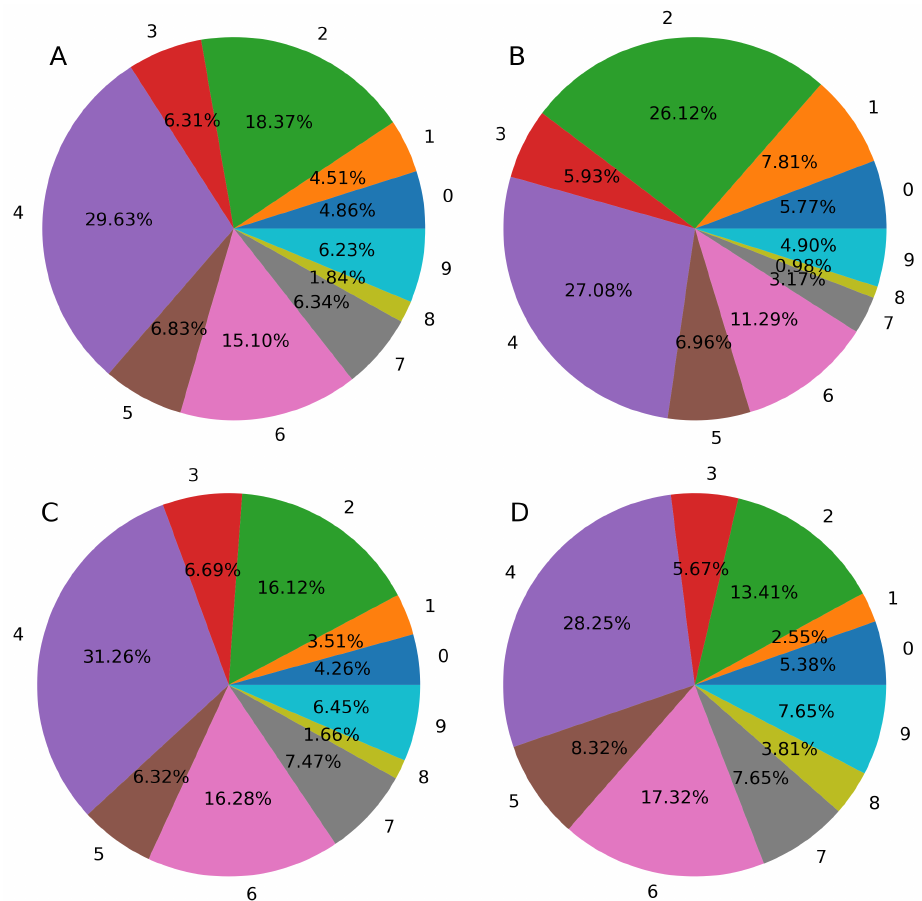
Figure 4. Percentage of tweets in the 10 clusters during 4 different time periods: chart A shows the overall tweet count percentages by cluster, chart B covers the first wave of the COVID-19 pandemic chart D covers the third wave (26 February 2021–31 May